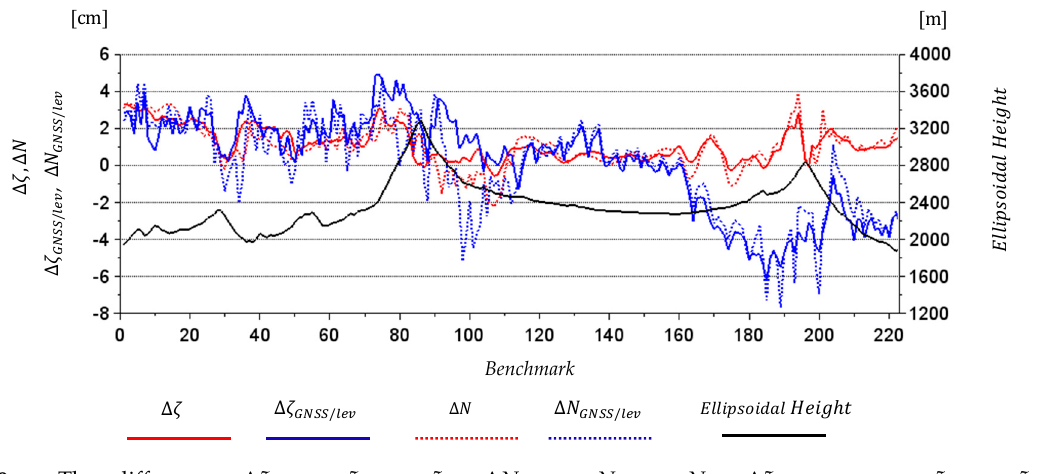
Figure 9. The differences ∆ ζ = ζ GGI − ζ m , ∆ N = N GGI − N m , ∆ ζ GNSS / lev = ζ GGI − ζ GNSS / lev , ∆ N = N − N GGI GNSS / lev GNSS / lev , and ellipsoidal heights at GSVS17 points. From the of 90 cm were removed.